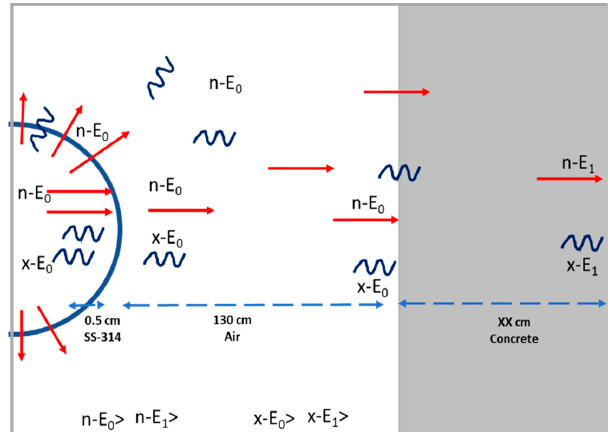
Figure 2. The model used to investigate the thickness of shielding material needed for the IECF system is illustrated. n–E i and x–E i refer to the neutron and X-ray energies generated from the IECF and a tt enuated through the shielding material.